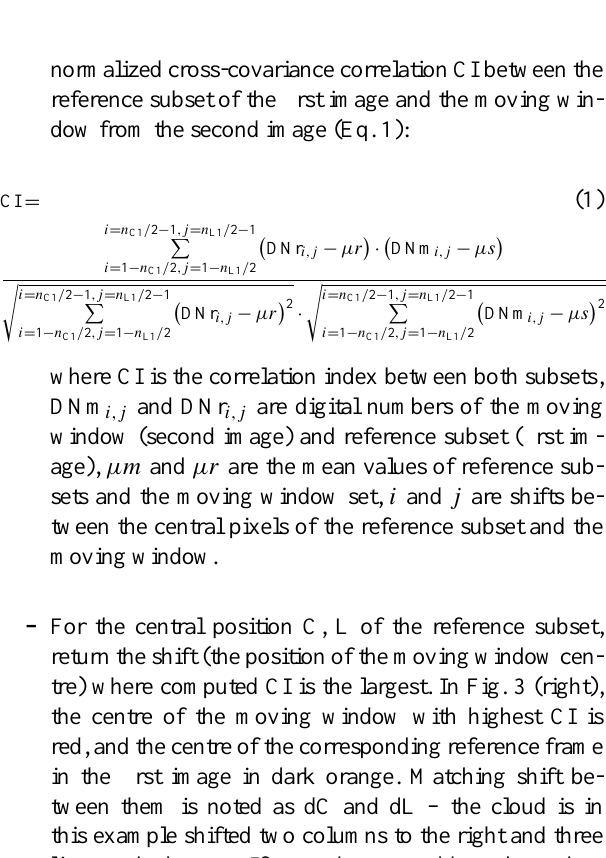
Fig. 3. Schema of area-based image matching. For more details see